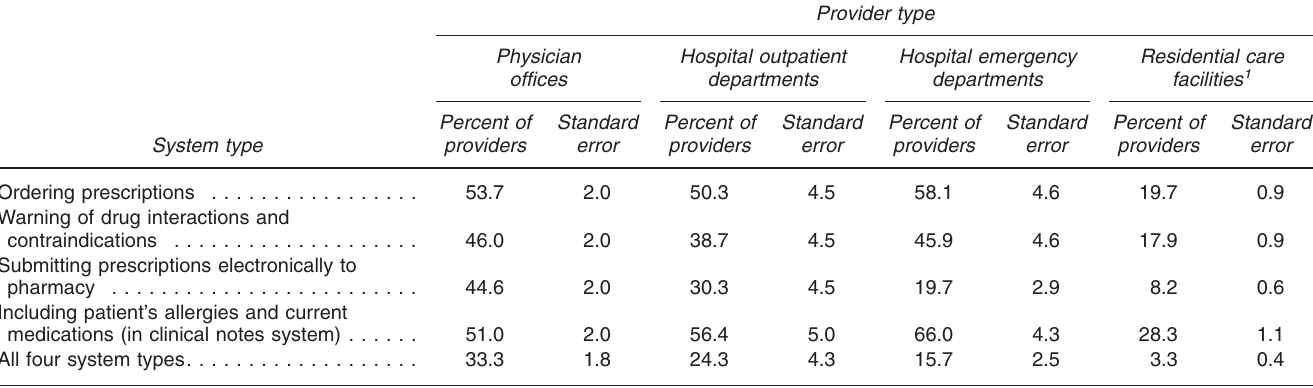
Data table for Figure 27. Computerized systems for prescription drugs, by provider and system type: United States, 2010 Excel and PowerPoint: